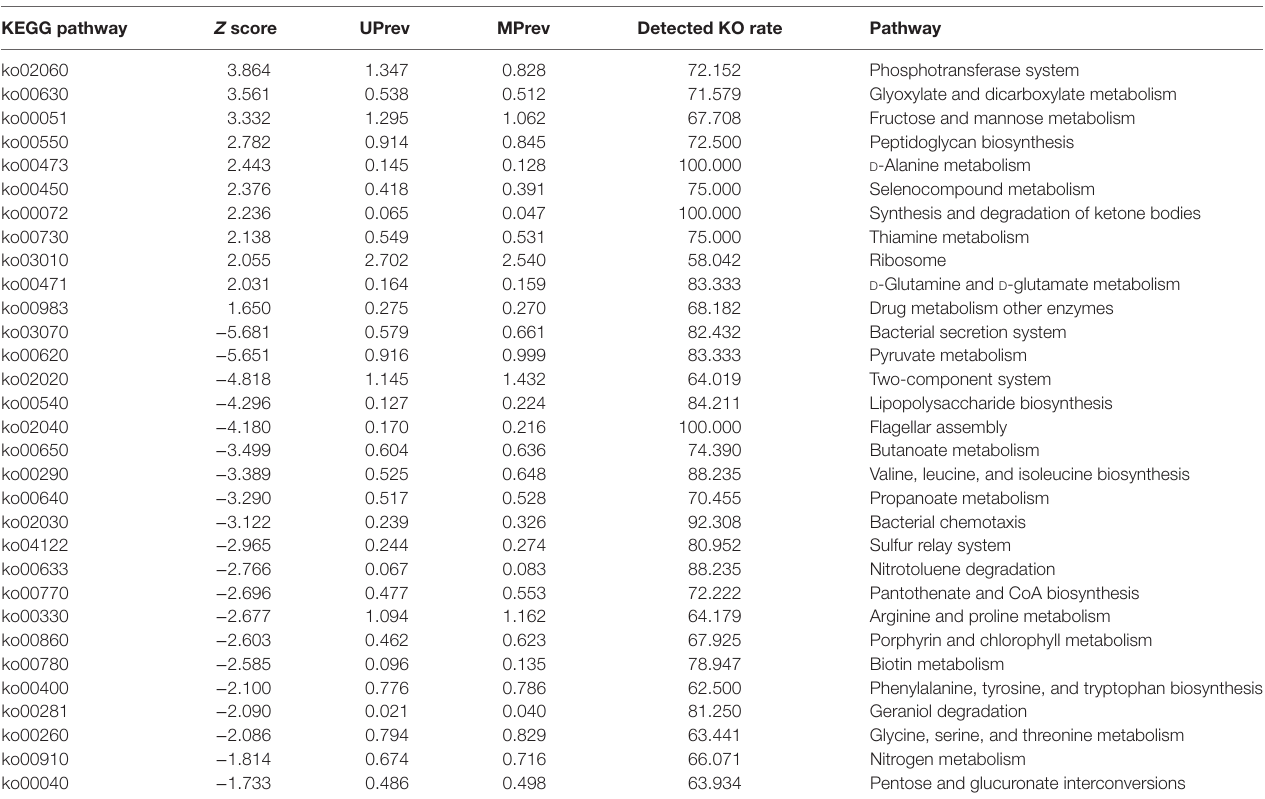
Pentose and glucuronate